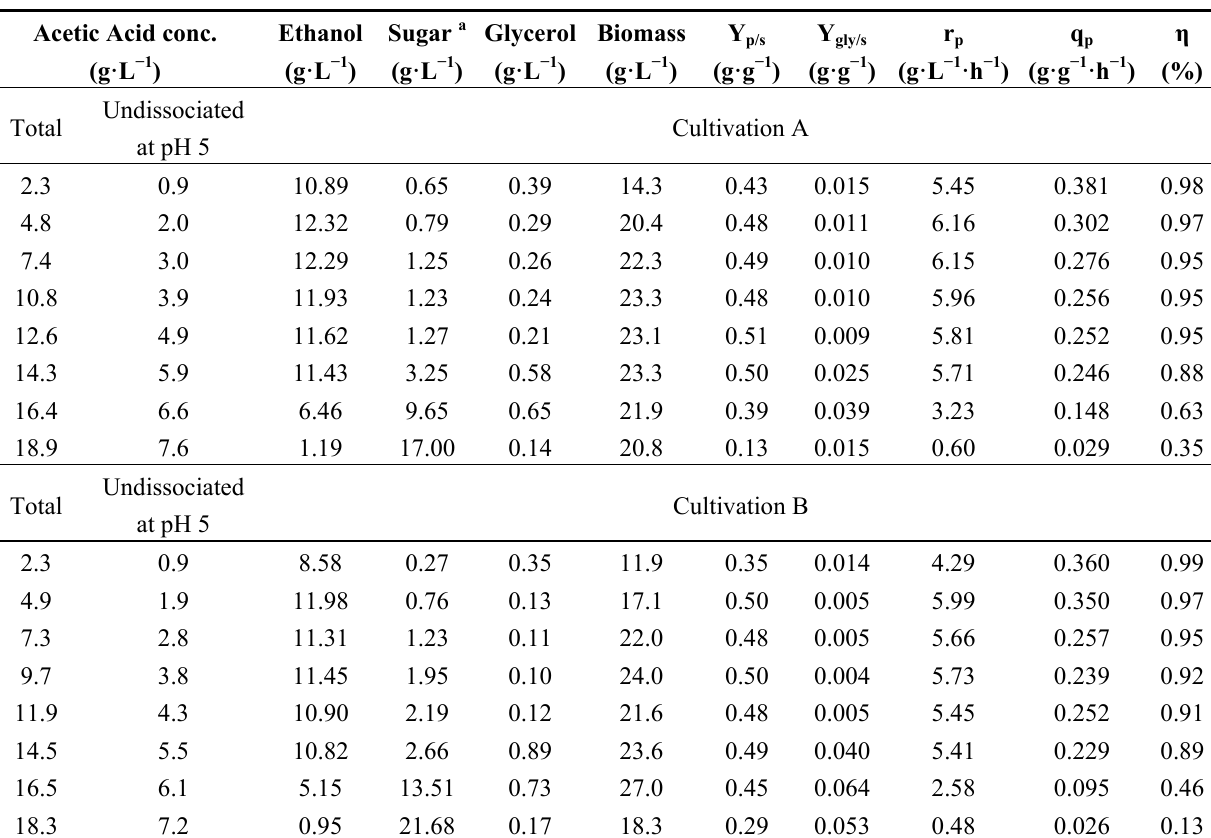
Table 2. Product yields and ethanol productivity during continuous fermentations at high yeast concentrations. Acetic Acid